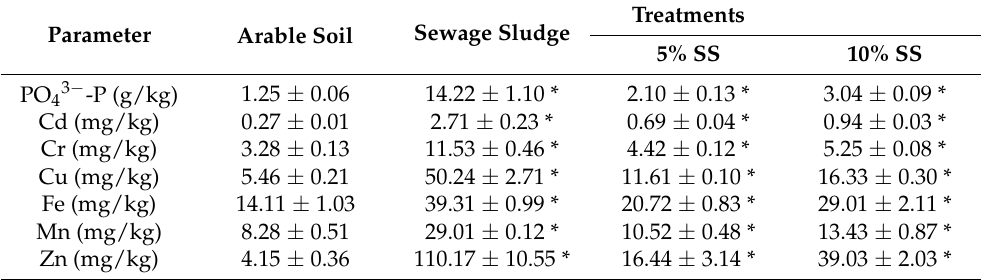
Table 1. Cont. Parameter